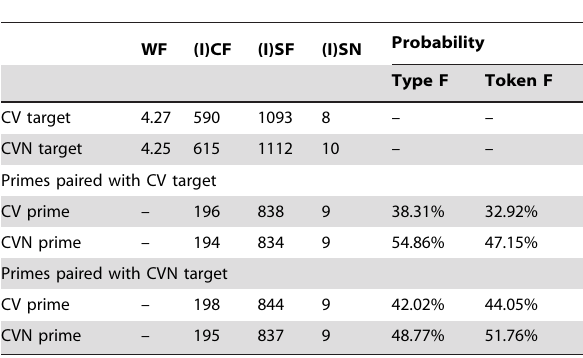
Table 2. Properties of the stimuli used in Experiment 2. Table 3. Mean naming latencies (in ms) and mean